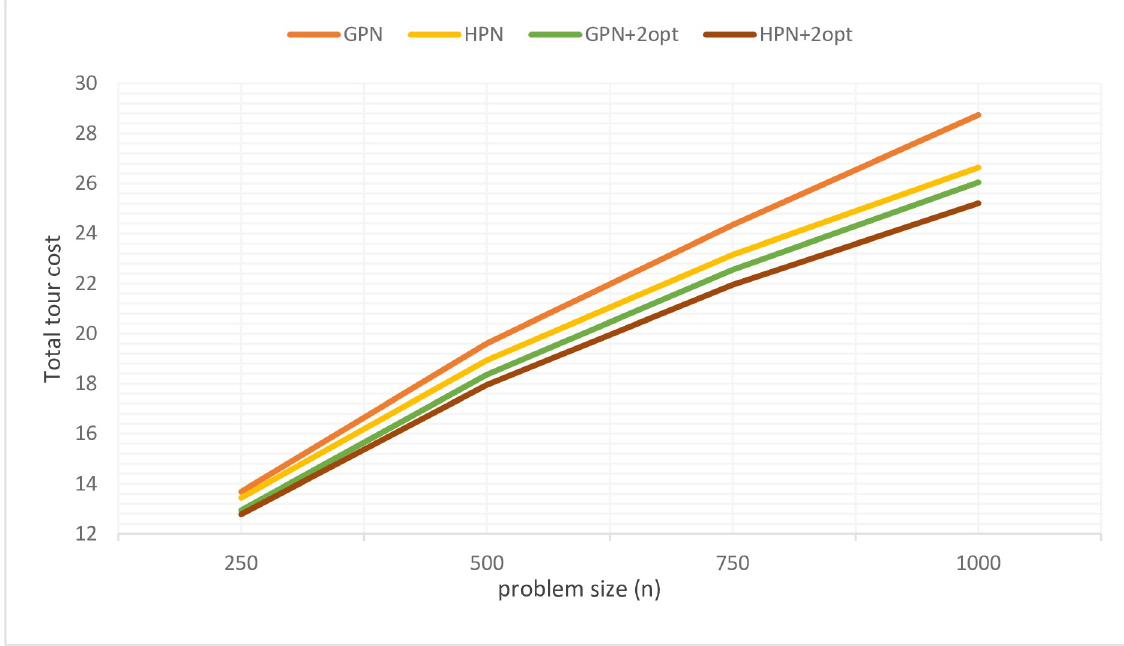
Fig 7. Large-scale results from GPN, HPN, GPN+2opt, and HPN+2opt demonstrate that the gap between our model and GPN increases as the problem size increases.